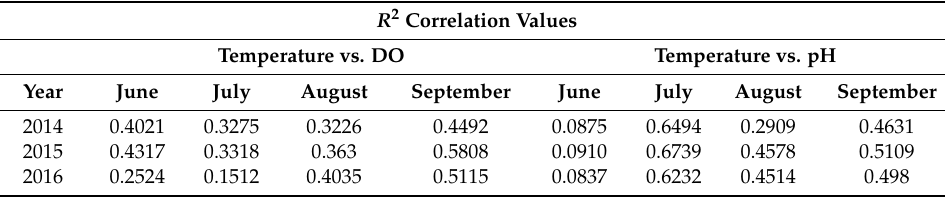
Figure 5. Stream behavior based on stream water temperature during the three summer months and the first fall month for three consecutive years. Table 2. Results of correlation coefficient for linear regression ( R 2 ) values of temperature and DO and temperature vs. pH from 2014 to 2016.